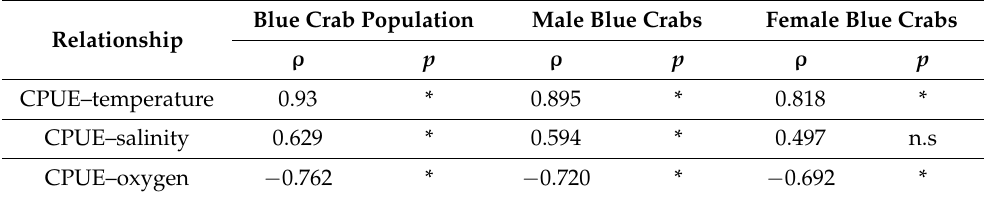
Table 1. Spearman’s rank–order correlation results for the relationships (a) CPUE–temperature, (b) CPUE–salinity, and (c) CPUE–oxygen of the blue crab Callinectes sapidus in Monolimni Lagoon and the adjacent coastal area ( ρ = Spearman’s correlation coefficient, * = significance at p < 0.05, n.s =